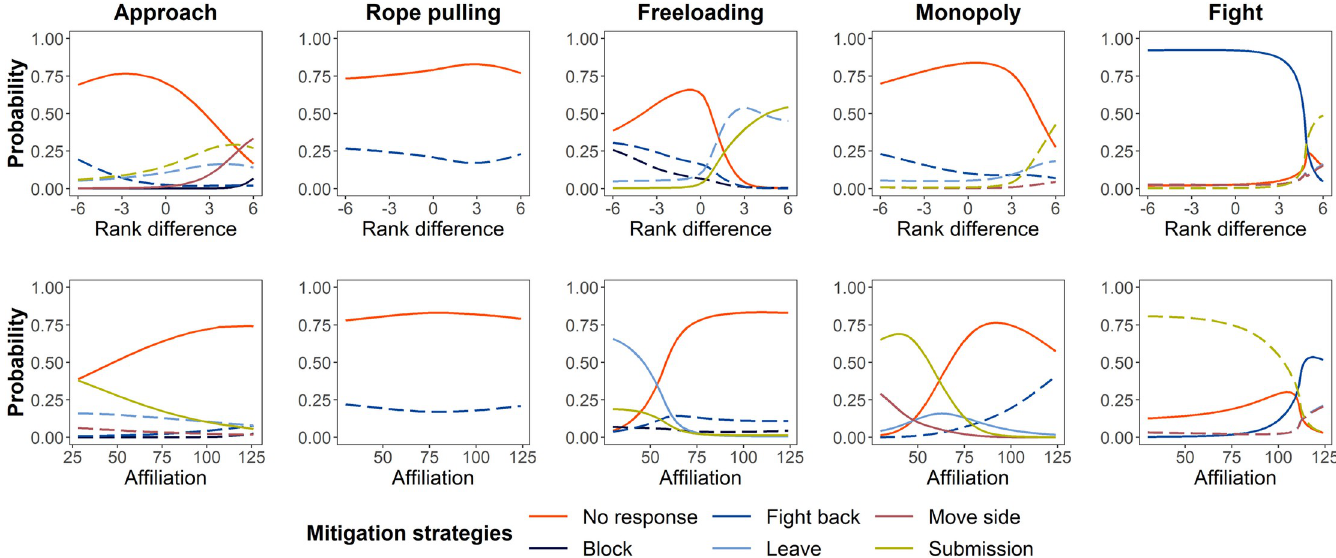
Fig 5. Mitigation strategies used by elephants in Phase II based on their rank difference with a partner (top) or their level of affiliation (bottom). Rank difference was calculated using the ranking of the initiator elephant minus the ranking of the target elephant. A positive rank difference means the initiator was dominant to the target elephant, while a negative value means the initiator was of lower rank. The only exception to this is that the rank difference under the “rope-pulling” competition type was calculated as the absolute value of the rank difference between the initiator elephant and the target elephant because we could not differentiate between the initiator and target when the 2 elephants were pulling a single rope. The maximum affiliation index was 126. A solid line means that the probability of a mitigation strategy being used by an elephant can be predicted by rank difference (top plots) or affiliation (bottom plots), while long dashed lines represent nonsignificant patterns. The solid red line (no response) was set as a reference level in the models. The data used to generate this figure can be found in S1 Data.